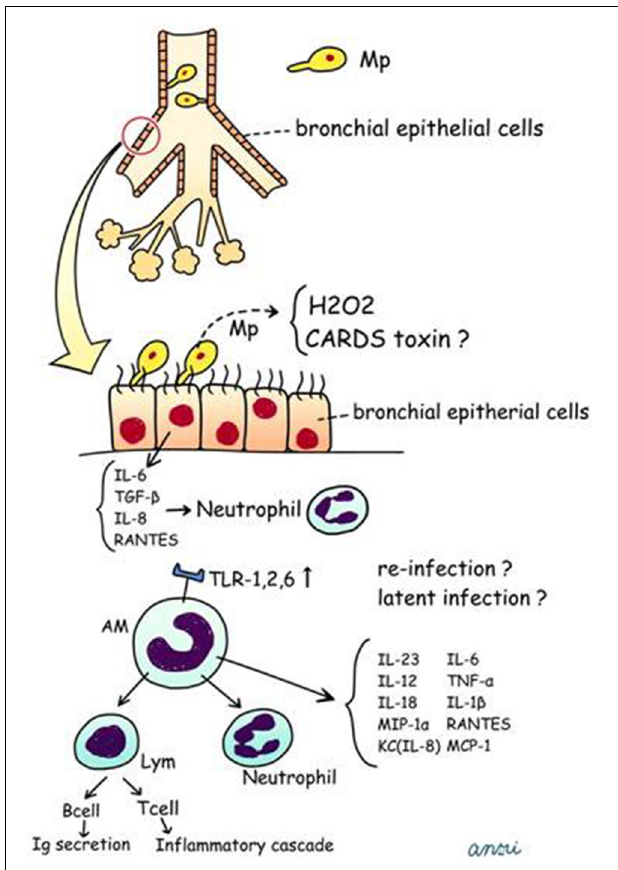
FIGURE 5 | Postulated schema for pathogenesis of human Mp pneumonia. CARDS, Community Acquired Respiratory Distress Syndrome; TNF, tumor necrosis factor; RANTES, regulated on activation; normal T cell expressed and secreted; MCP-1, monocyte chemotactic protein-1.